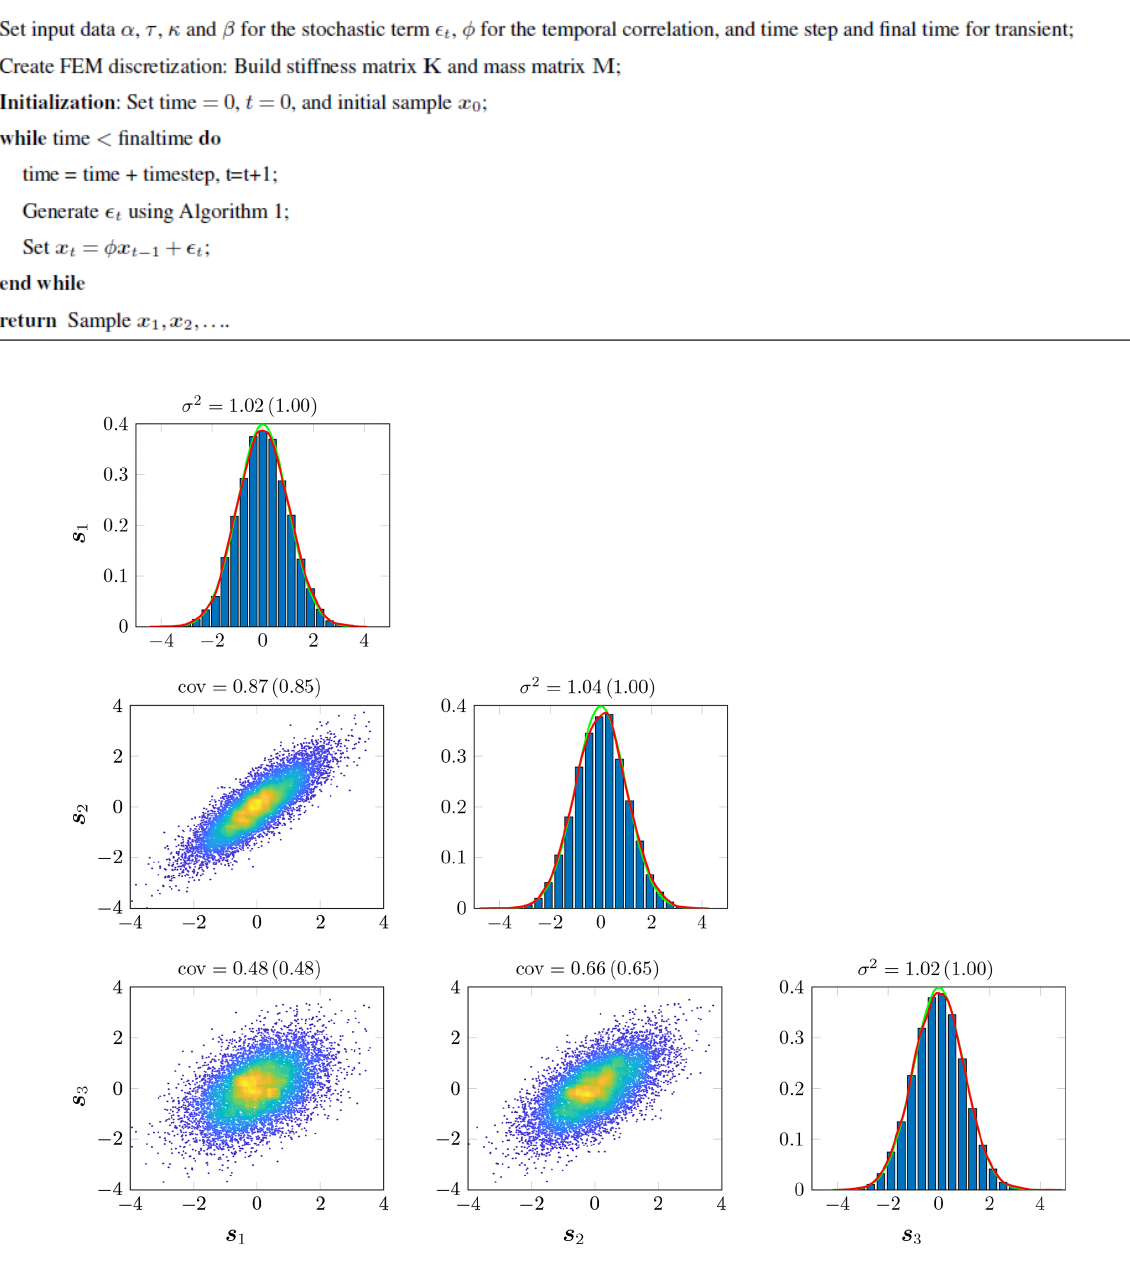
Figure 1. Estimated marginal and bivariate distributions of the samples generated by solving the SPDE (Eq. 2) with α = 2. Estimates are based on 10000 samples. Results are shown for the locations s 1 = ( 50 , 50 ) km, s 2 = ( 53 . 125 , 50 ) km and s 3 = ( 59 . 375 , 50 ) km. The estimated covariances and variances are also provided with the theoretical values determined from Eq. (1) shown in parentheses. For the marginal distributions, the red curves represent the kernel density estimates and the green curves are standard Gaussian